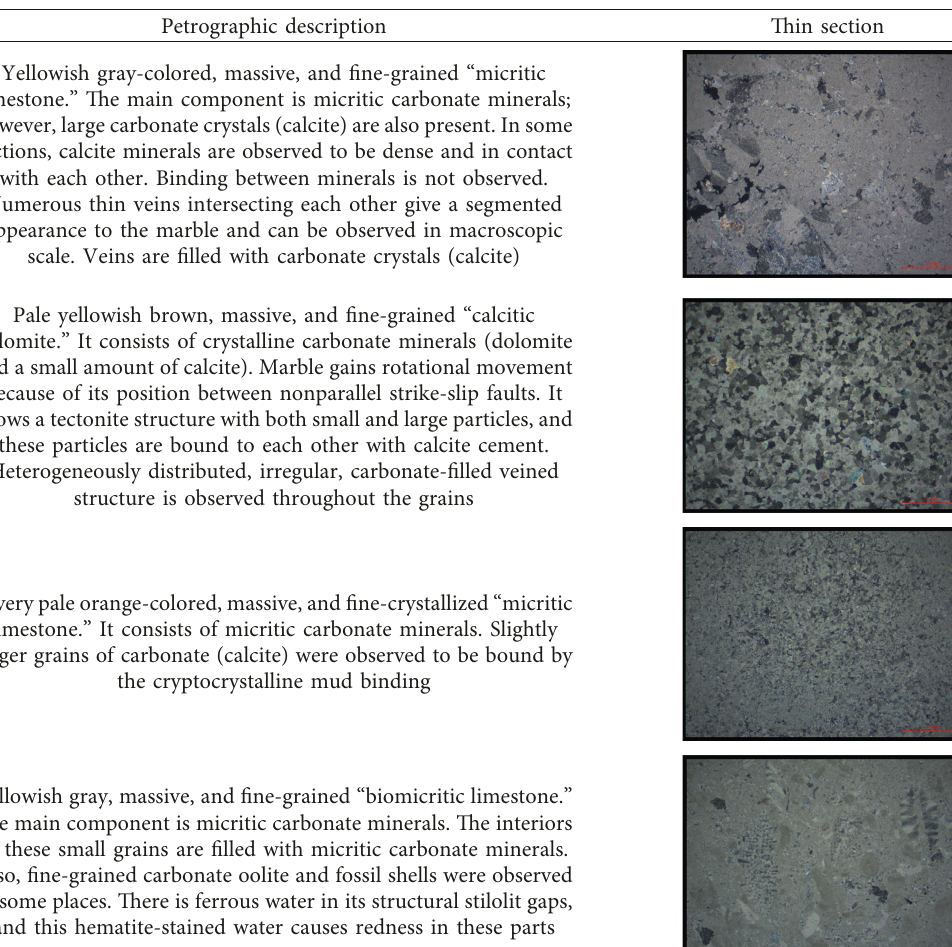
Table 3: Mineralogical and petrographical characterizations of the marble